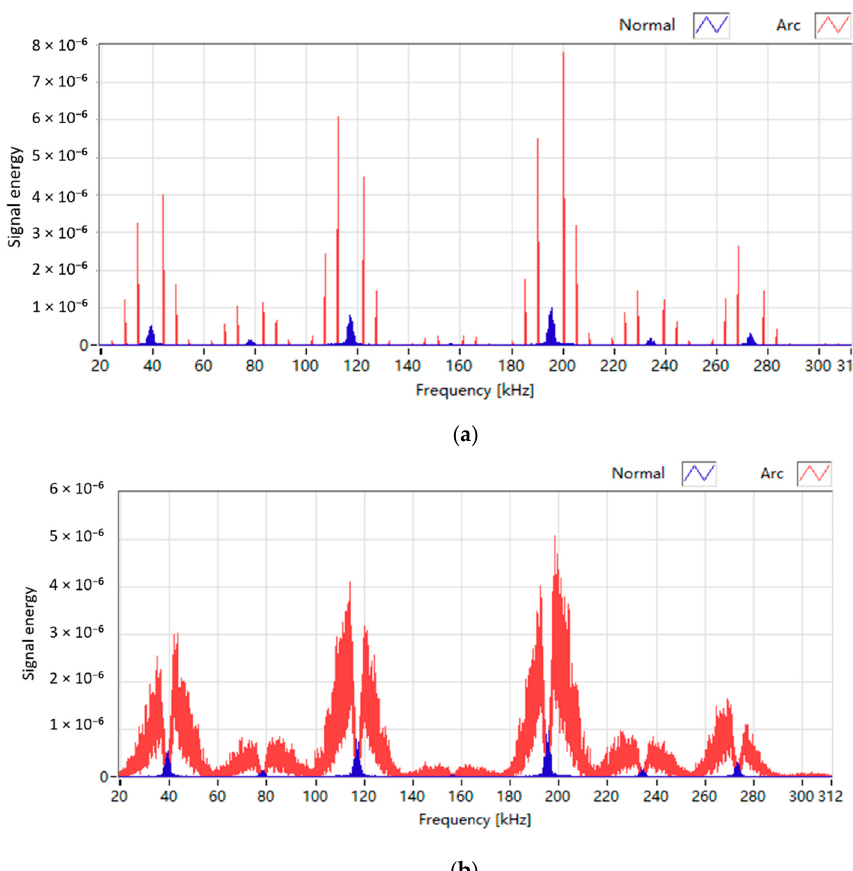
Figure 13. Power spectrum of the extracted signal. ( a ) cord-cord; ( b ) carbon-copper.